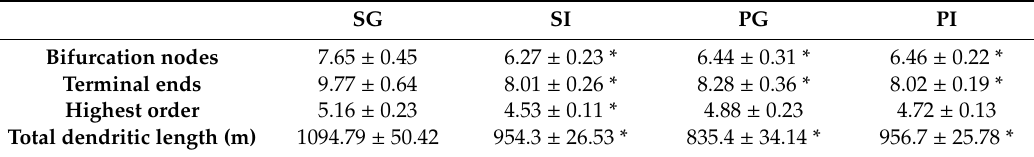
Table 2. Morphometric features of DG granule cells. Data are presented as the mean ± SEM. SG: n = 31 neurons, SI: n = 49 neurons, PG: n = 32 neurons, PI: n = 65 neurons; neurons were obtained from 6 mice in all groups. * p < 0.05 compared to the SG